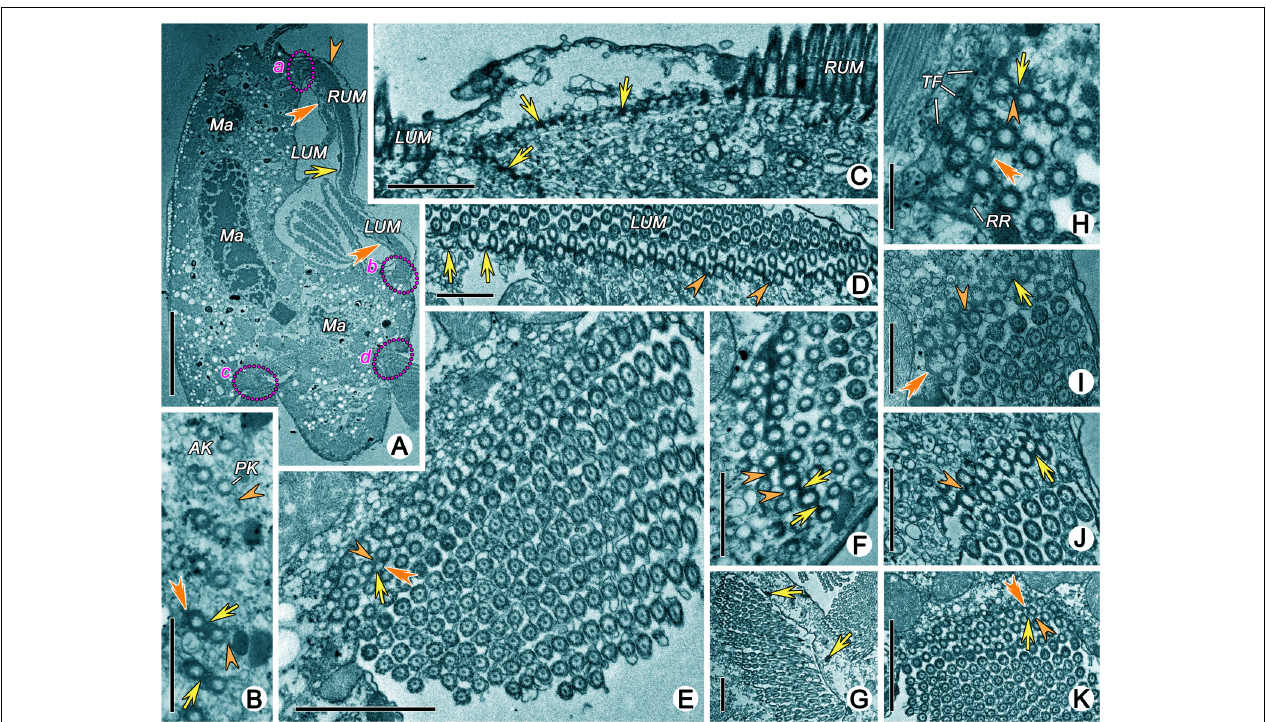
FIGURE 5 | Transmission electron micrographs of ciliature of Uronychia binucleata . (A) Longitudinal section of cell from right lateral view, to show the membrane structure located outside of right component of the undulating membrane (arrowhead), inside of right component of undulating membrane (arrows), and inside of left component of the undulating membrane (double-arrowhead). Areas marked “a” “b” “c” and “d” are enlarged in (J,F,E,K) , respectively. (B) Oblique section of dorsal kineties, showing the connections between the anterior (AK) and posterior (PK) kinetosomes. Arrows mark the inter-kinetosomal connective, arrowheads point to kinetodeamal fiber, double-arrowhead indicates the tangential transverse ribbon. (C) Section of anterior part of cell showing continuous fibrous layer (arrows) connects the kinetosomes in left and right components of the undulating membrane. (D) Cross section of left component of the undulating membrane, to show the show the diagonal connections (arrowheads), some of which forms a series of crescent-like structures (arrows). (E) Cross section of caudal cirri, showing the connections among kinetosomes. Arrowhead marks the double linkages between kinetosomes in the same row, arrow points to the diagonal connection, and double-arrowhead indicates the transverse connection. (F,I,J) Cross section of left (F,J) and right (I) components of the undulating membrane showing the kinetosomes linked by double linkages (arrows) and diagonal connections (arrowheads). Double-arrowhead marks a crescent-like structure in left component of the undulating membrane. (G) Cross section of adoral zone of membranelles 2 consisting of three rows in each membrane. Arrows point to the extrusomes. (H) Detailed magnification of a membrane from adoral zone of membranelles 2, to show the diagonal connection (double-arrowhead) interconnects posterior row and extends out to form radial ribbon of microtubules (RR). Arrow points to anterior connection, arrowhead marks the posterior connections. (K) Cross section of transverse cirri. Arrowhead marks electron-dense double linkages linked kinetosomes in the same row, arrow points to the diagonal connection, double-arrowhead indicates the transverse connection. AK, anterior kinetosome; LUM, left component of the undulating membrane; Ma, Macronuclear nodule; PL, posterior kinetosomes; RUM, right component of the undulating membrane; RR, radial ribbon of microtubules; TF, terminal fiber. Scale bars = 10 µ m (A) , 1 µ m (B–D,F,I,J) , 2 µ m (E,G,K)